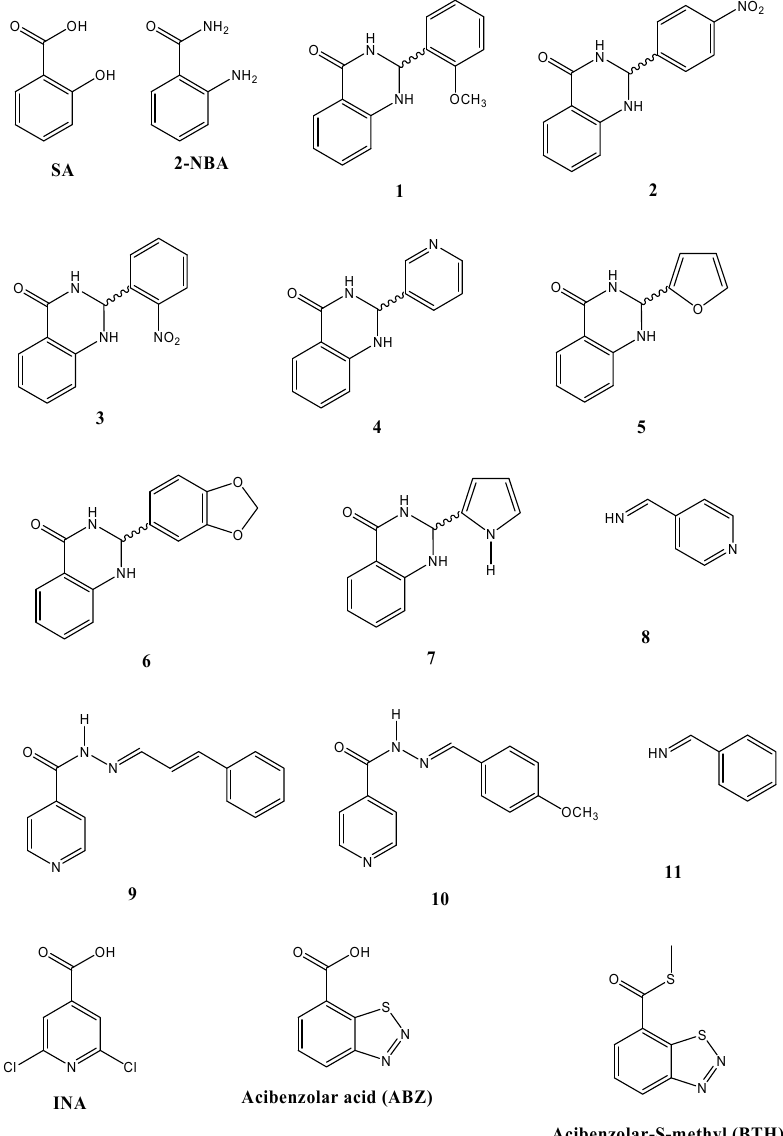
Figure 5. Chemical structures of compounds evaluated as